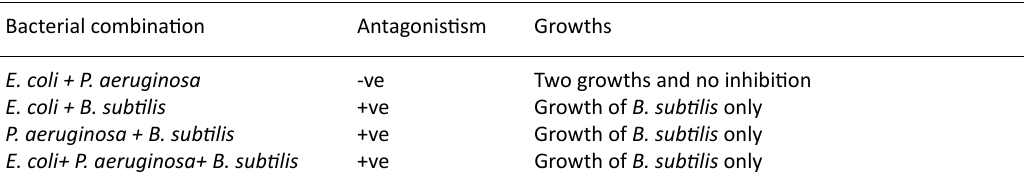
table 6. Antagonistic activity of the isolated bacterial species Bacterial combination Antagonistism Growths -ve Two growths and no inhibition